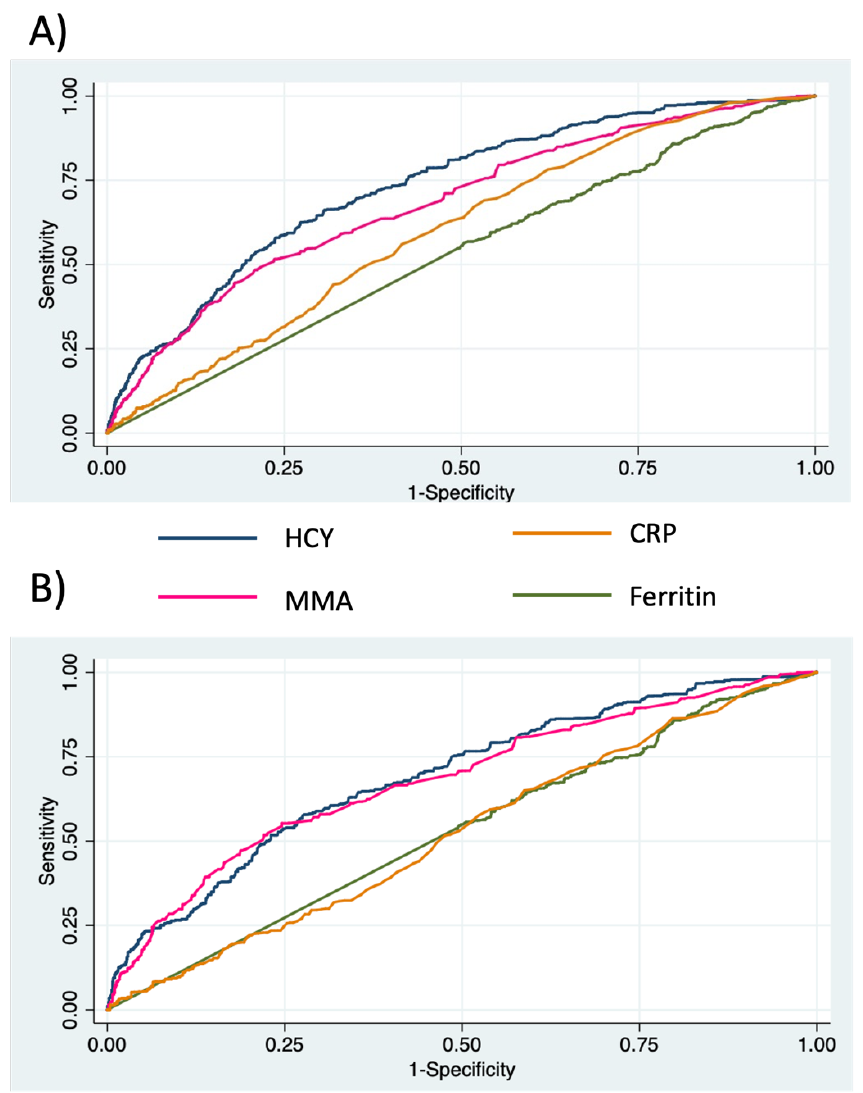
Figure 2. Receiver operator curve (ROC) of biomarkers in all participants ( A ) and participants with NAFLD ( B ). MMA, methylmalonic acid; HCY, homocysteine. CRP: c-reactive protein. NAFLD ( B ). MMA, methylmalonic acid; HCY, homocysteine. CRP: c-reactive